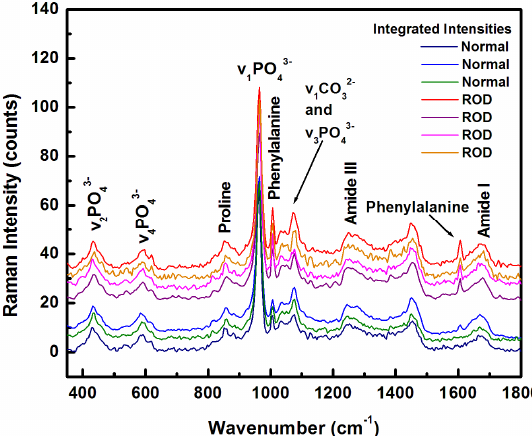
Figure 1. Integrated Raman spectra of 3 normal and 4 renal osteodystrophy (ROD) bone samples, each obtained by averaging 22,500 Raman spectra. The spectra are vertically translated and color labeled for easier visualization.